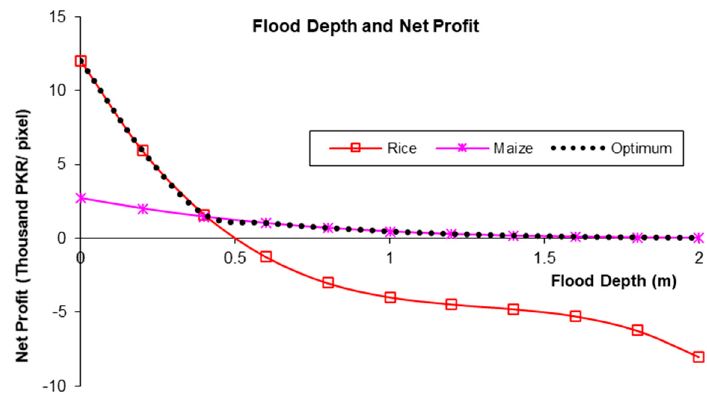
Figure 9. Reduction in profits due to flooding for maize and rice crops.